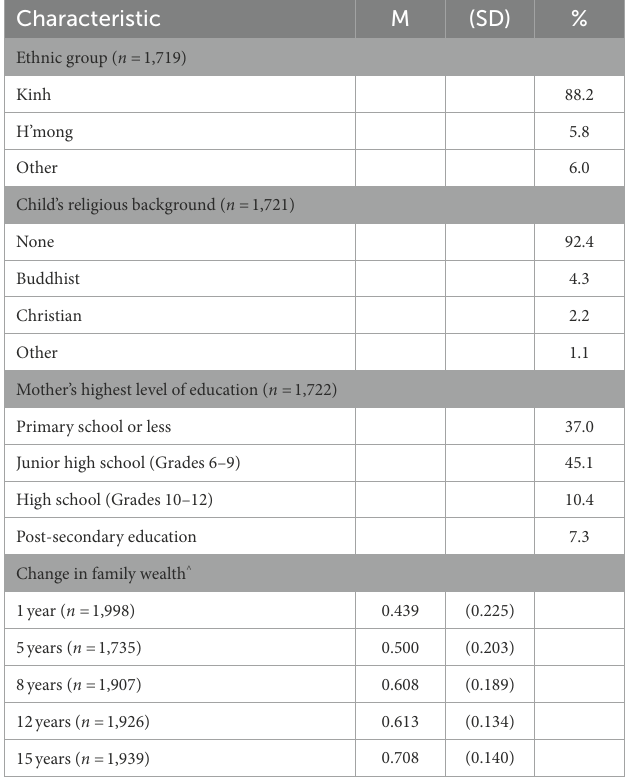
TABLE 1 Demographic characteristics of the sample.